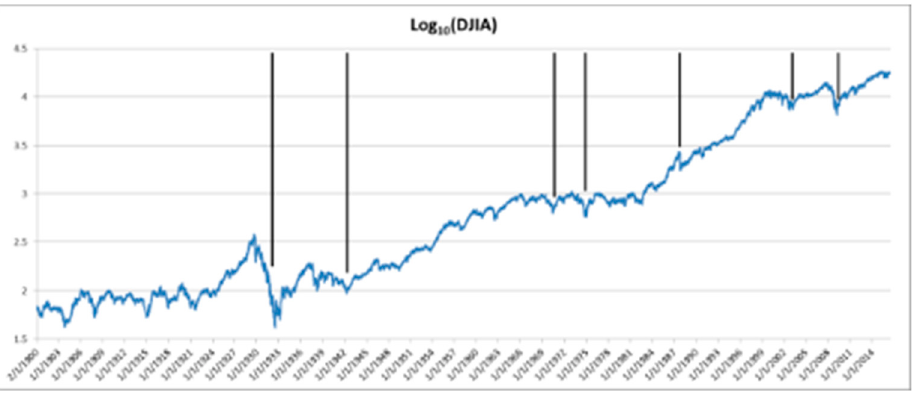
Figure 5. Periodically, the stock exchange suffers a significant correction. Source: Authors’ processing in Microsoft Excel is based on data available on http://stooq.com/q/?s=%5Edji (accessed on 20 July 2017).